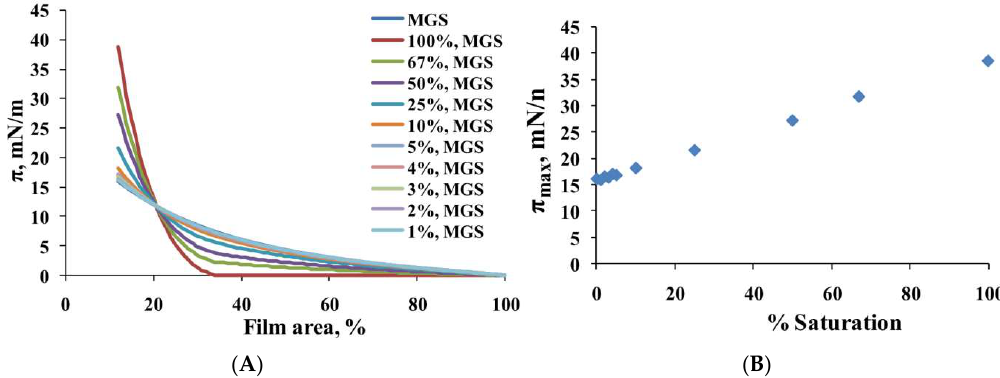
Figure 1. ( A ): Surface pressure (π)/area isotherms of human meibum (MGS) films, intact and with different degrees of catalytic saturation; ( B ): The dependence of maximum surface pressure (π max ) achieved at minimal surface area (at the completion of compression) on the degree of acyl chain catalytic saturation in MGS films. The higher the molecular packing density at the interface is, the higher π max is; higher cohesion between the lipid tails is thought to strengthen molecular packing (see Section 3 for details).